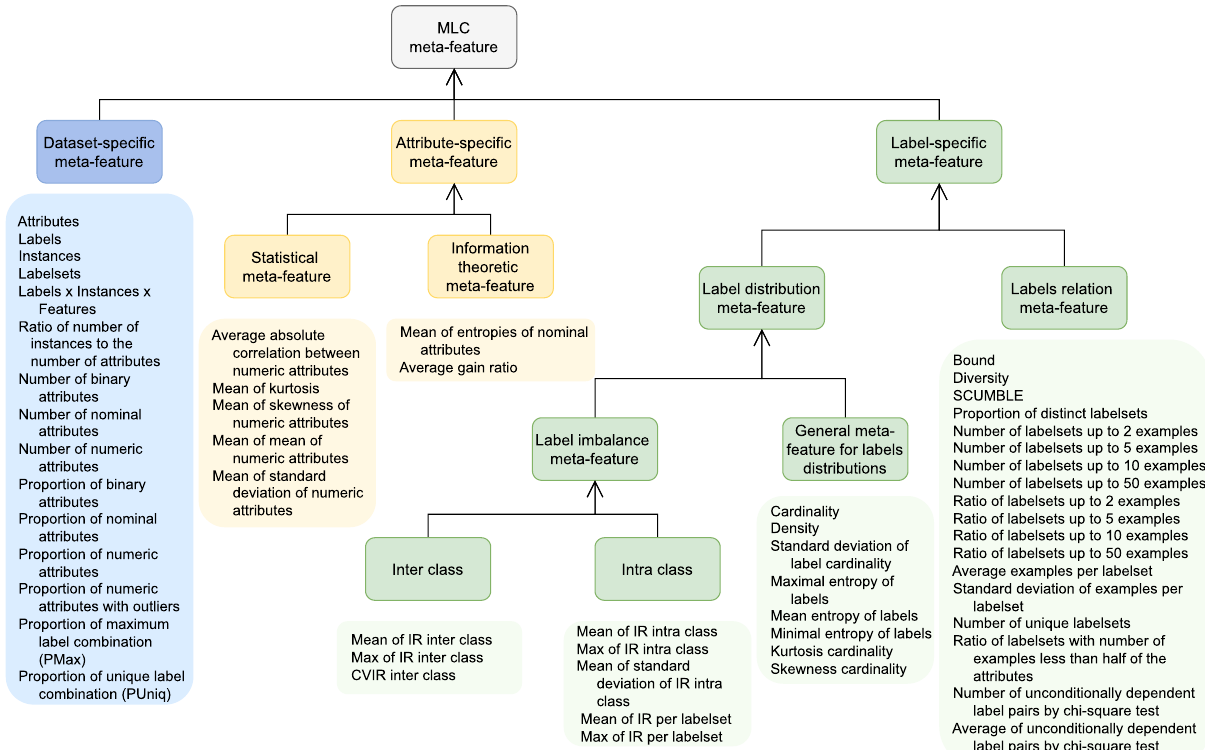
Figure 4. The taxonomy of meta-features for describing multilabel classification (MLC) data